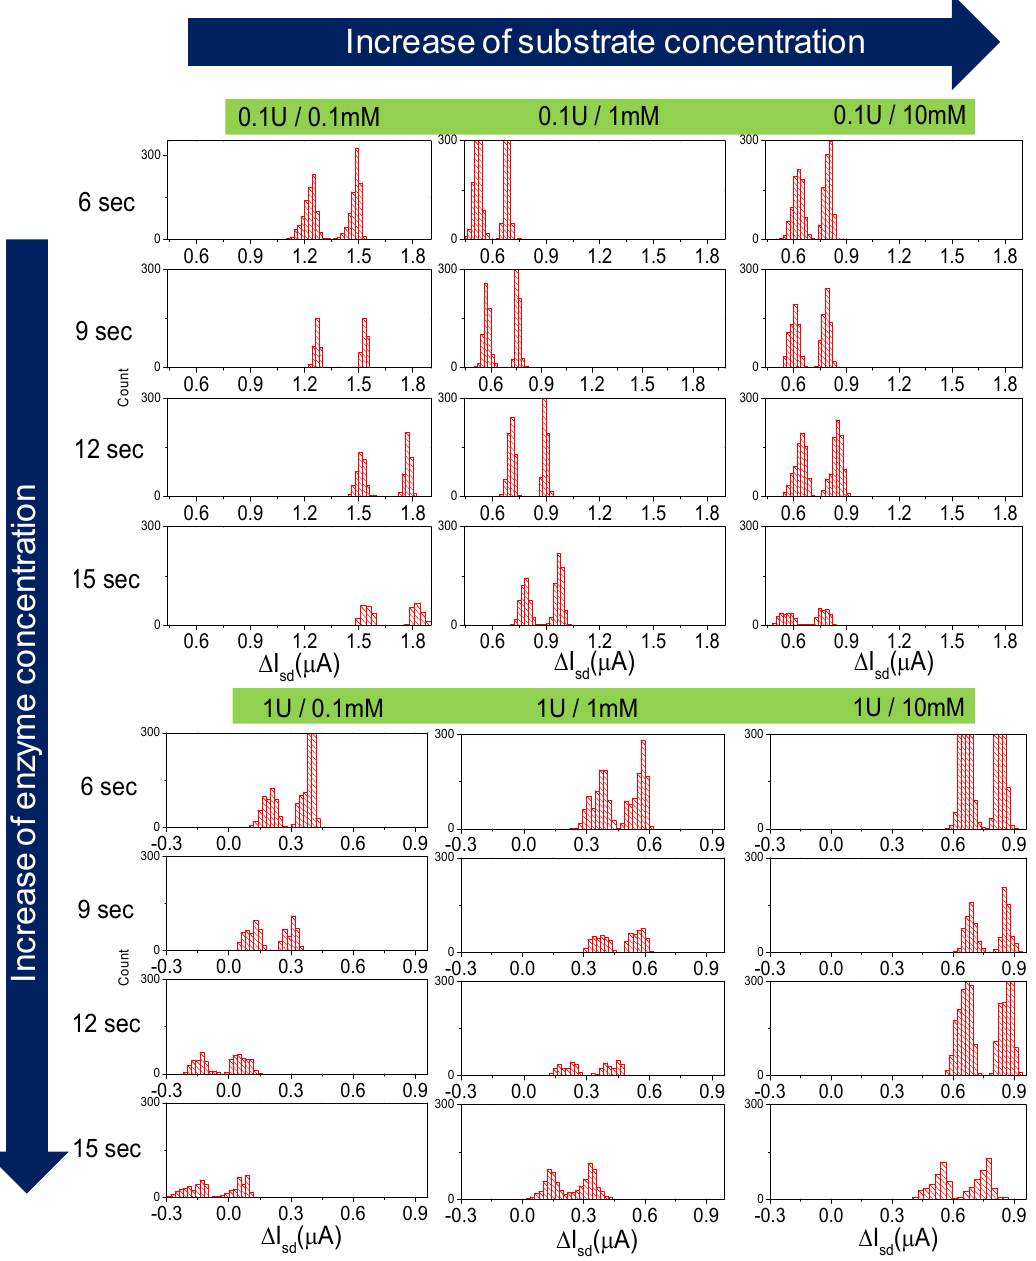
ff erent time points, concentrations, and peak Figure 5. Kinetics map of the reaction for different time points, concentrations, and peak values. Figure 5. Kinetics map of the reaction for di